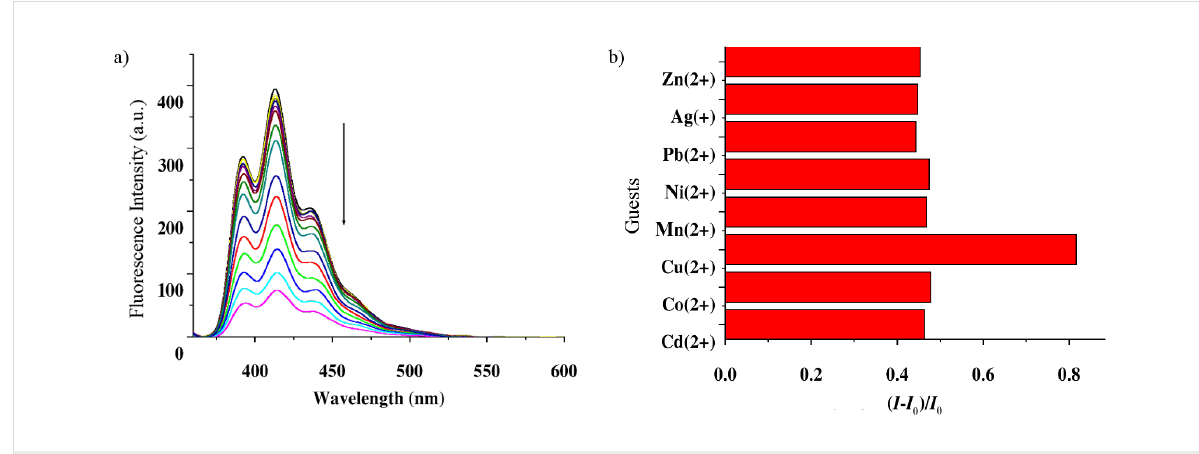
Figure 5: a) Emission spectra of receptor 2 ( c = 1.48 × 10 − 5 M) during titration with Cu 2+ ion ( c = 4.4 × 10 − 4 M) in CH 3 CN containing 0.02% DMSO ( λ ex = 348 nm); b) fluorescence ratio ( I - I 0 / I 0 ) of receptor 2 ( c = 1.48 × 10 − 5 M) at 413 nm upon addition of 20 equiv of a particular guest in CH 3 CN containing 0.02% DMSO ( λ ex = 348 nm).